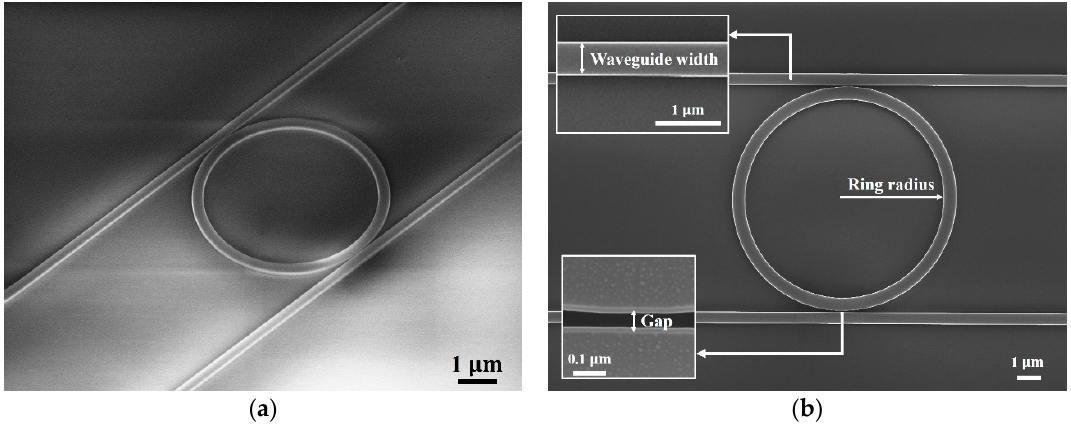
Figure 7. SEM image of fabricated MRR from ( a ) bird’s-eye view and ( b ) top view .